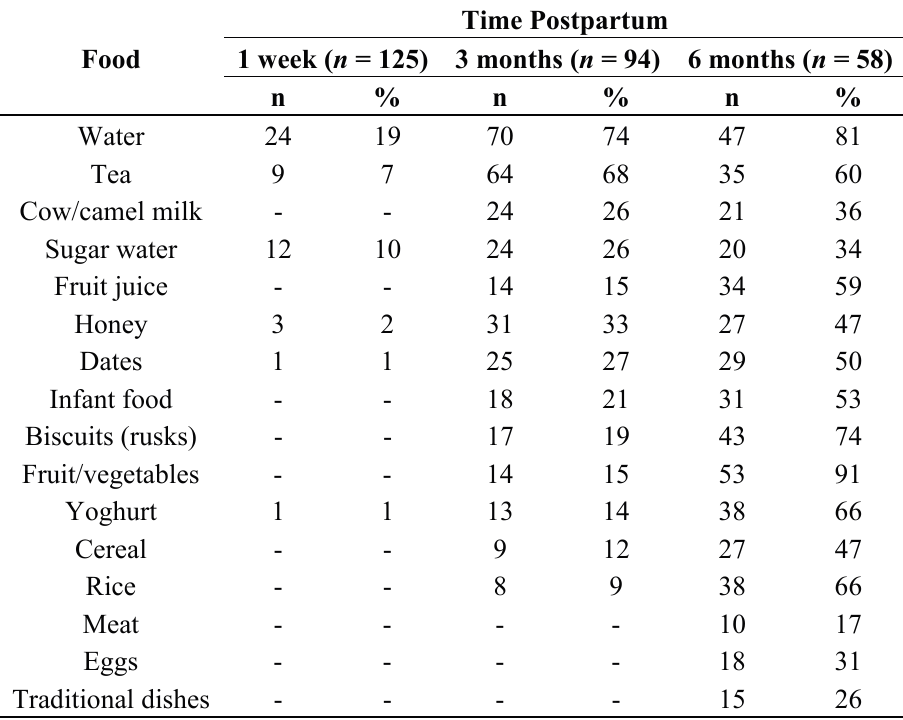
Table 3. Foods & drinks infants consumed by six months.